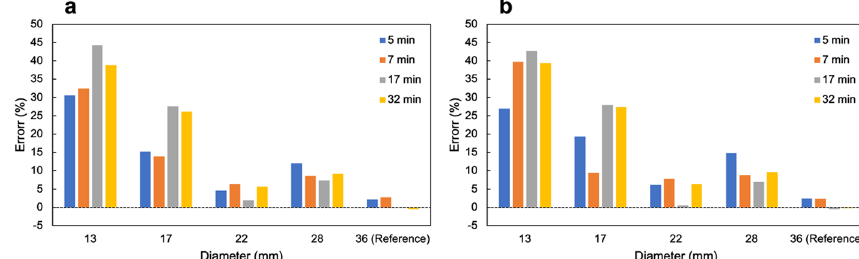
Fig. 10 Error per scan time in quantitative values at each tumor diameter for a SwiftScan SPECT and b step and shoot mode